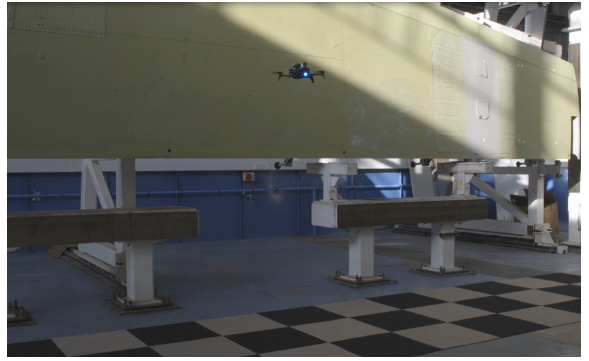
Figure 2. Aerial